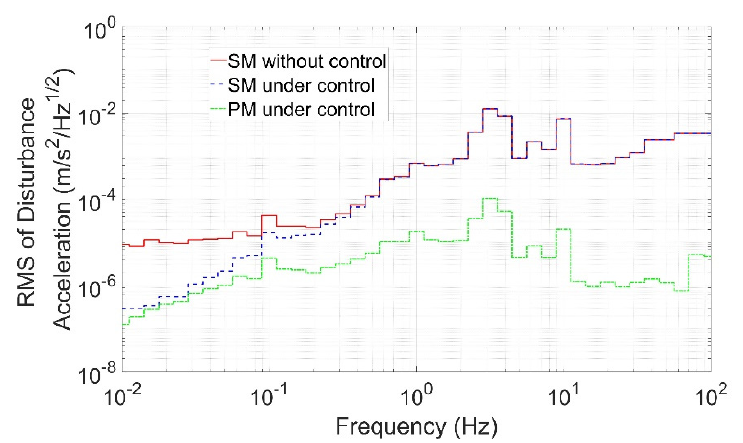
Figure 13. Disturbance acceleration of the improved DFP spacecraft.